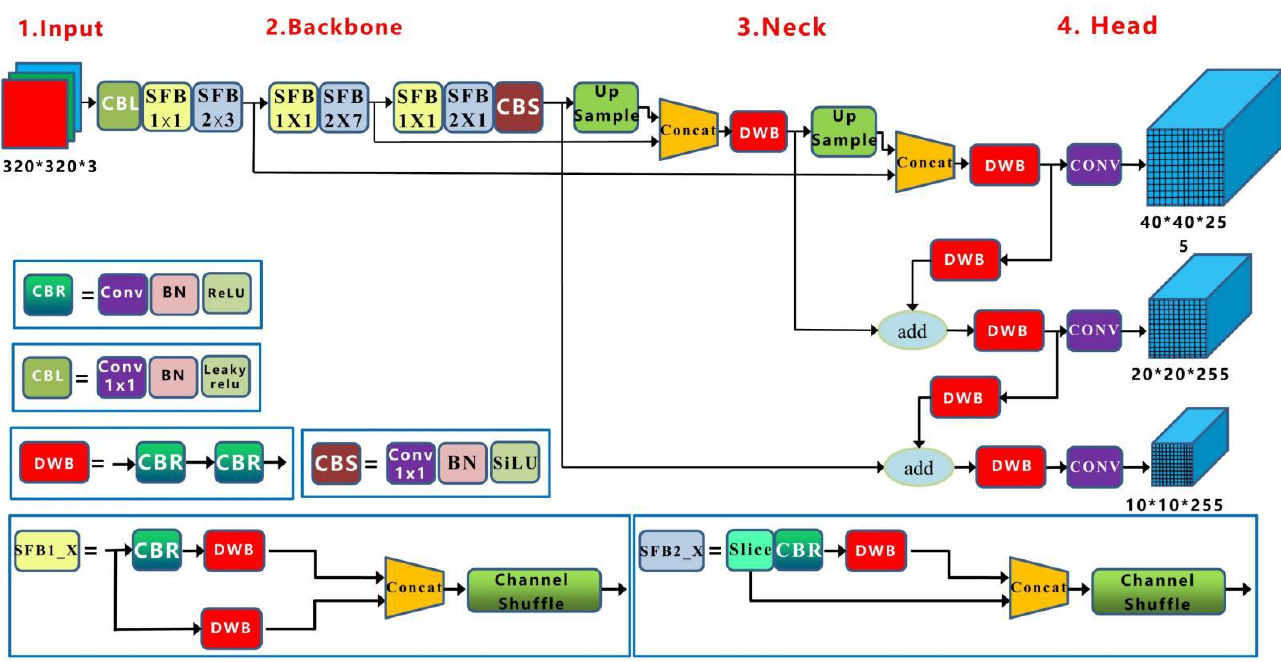
Figure 1. YOLOv5-lite overall structure.